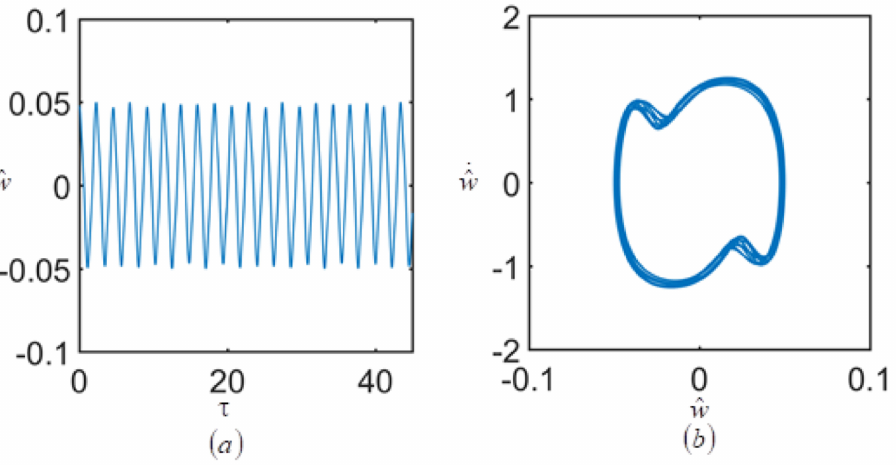
Figure 12. The nonlinear response for the CFRP laminated cylindrical shell with an excitation frequency in the unstable region: ( a ) the time history on the plane ( τ , ˆ w ) , and ( b ) the phase portrait . ˆ w ) on the plane ( ˆ w ,